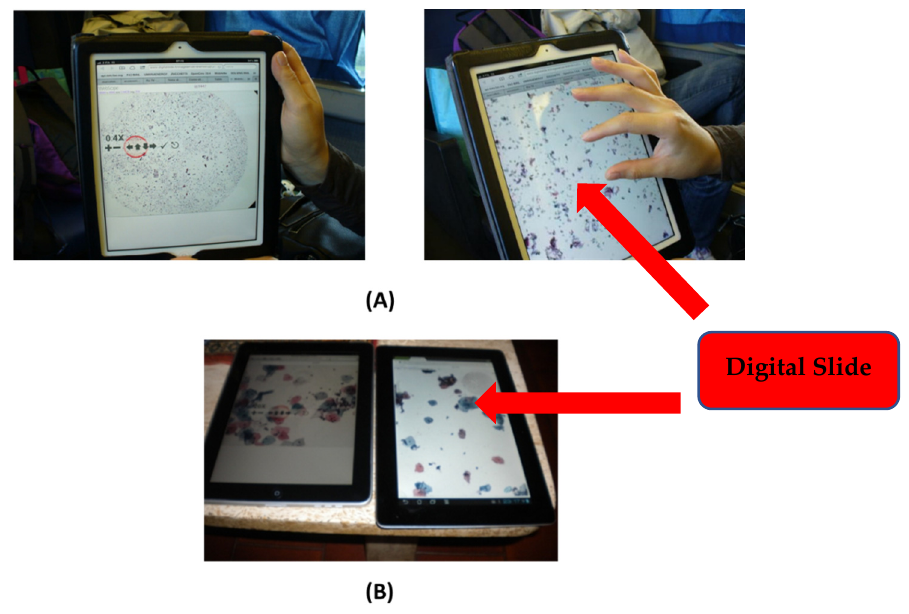
Figure 3. Access to the digital slides using mHealth ( A ) while navigating by a train without Wi-Fi; ( B ) a static connection.